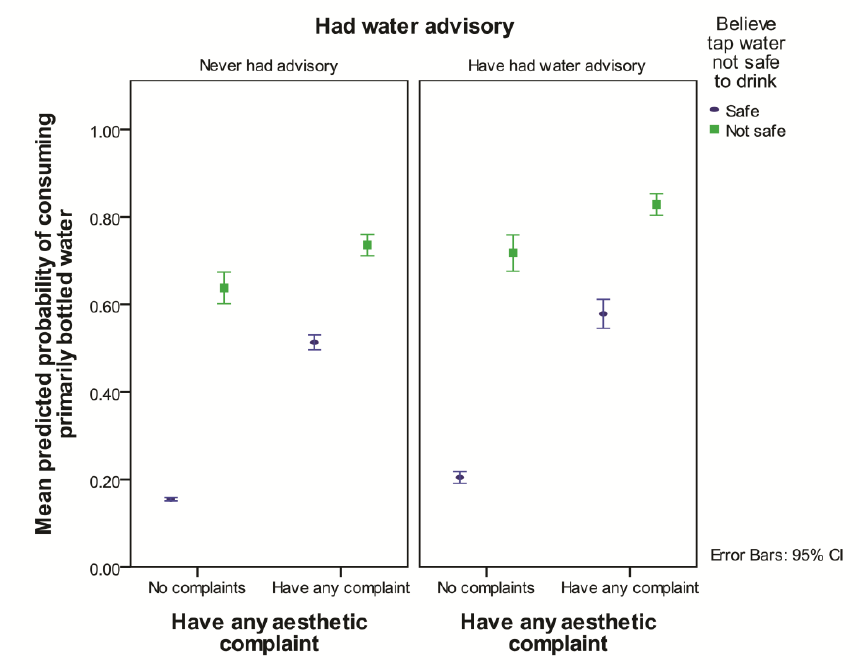
Figure 2. Predicted probability of consuming primarily bottled water by presence of aesthetic complaint and the belief that tap water is not safe to drink, separated by whether or not household had a water advisory in the past averaged over all length of time residing in area, whether a community water supply is used, and in-home treatment of tap water.